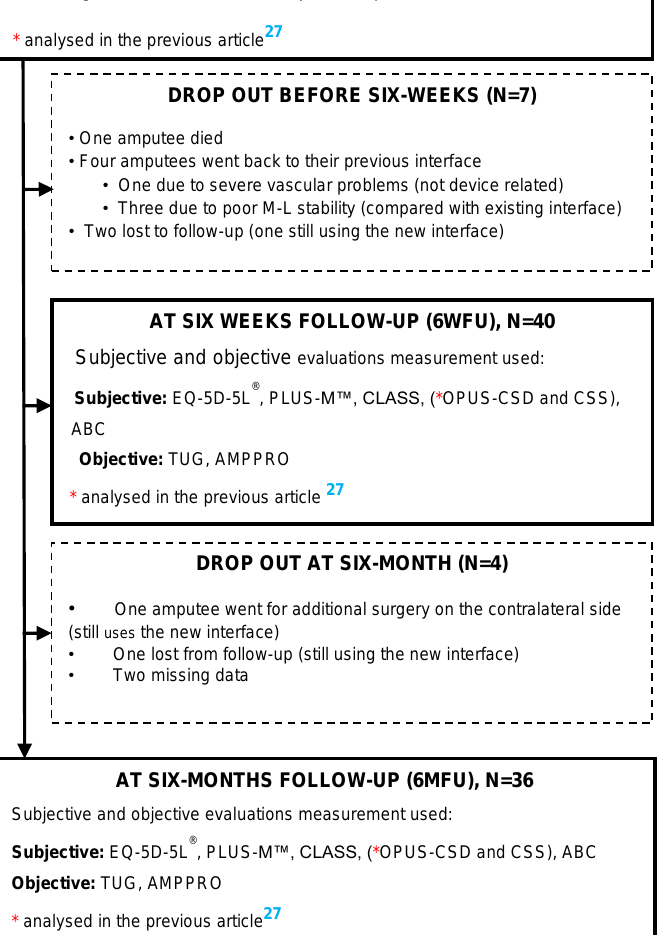
Figure 1: Flow chart of the